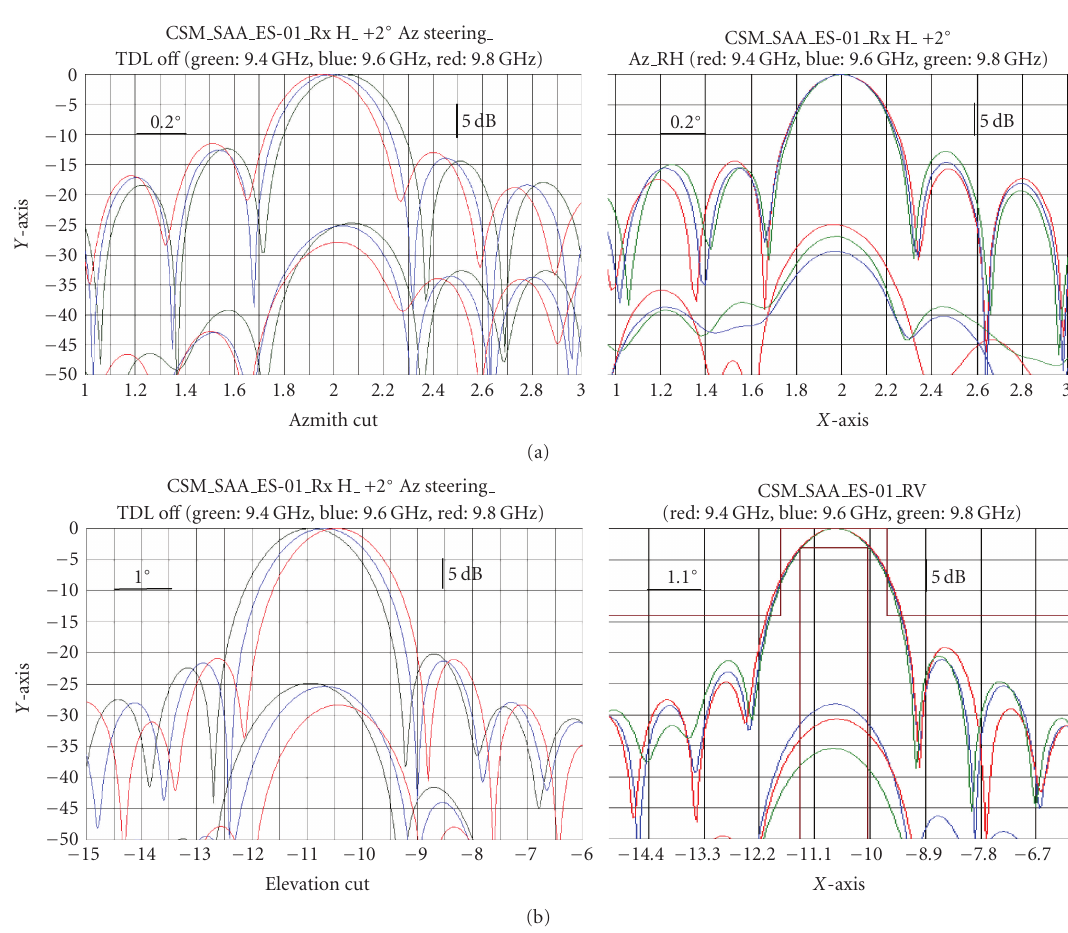
Figure 10: Example of the beam stabilization in the frequency band by using the TTDL (central and extremes frequencies are shown). (a) Azimuth plane (+2 ◦ of steering); (b) Elevation plane ( − 10 . 7 ◦ of steering).